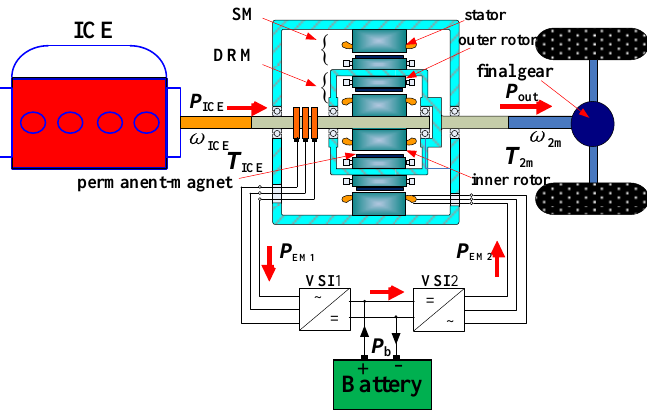
Figure 1. Schematic structure of the HEV based on the CSPM motor. SM, stator motor; DRM, double rotor motor.